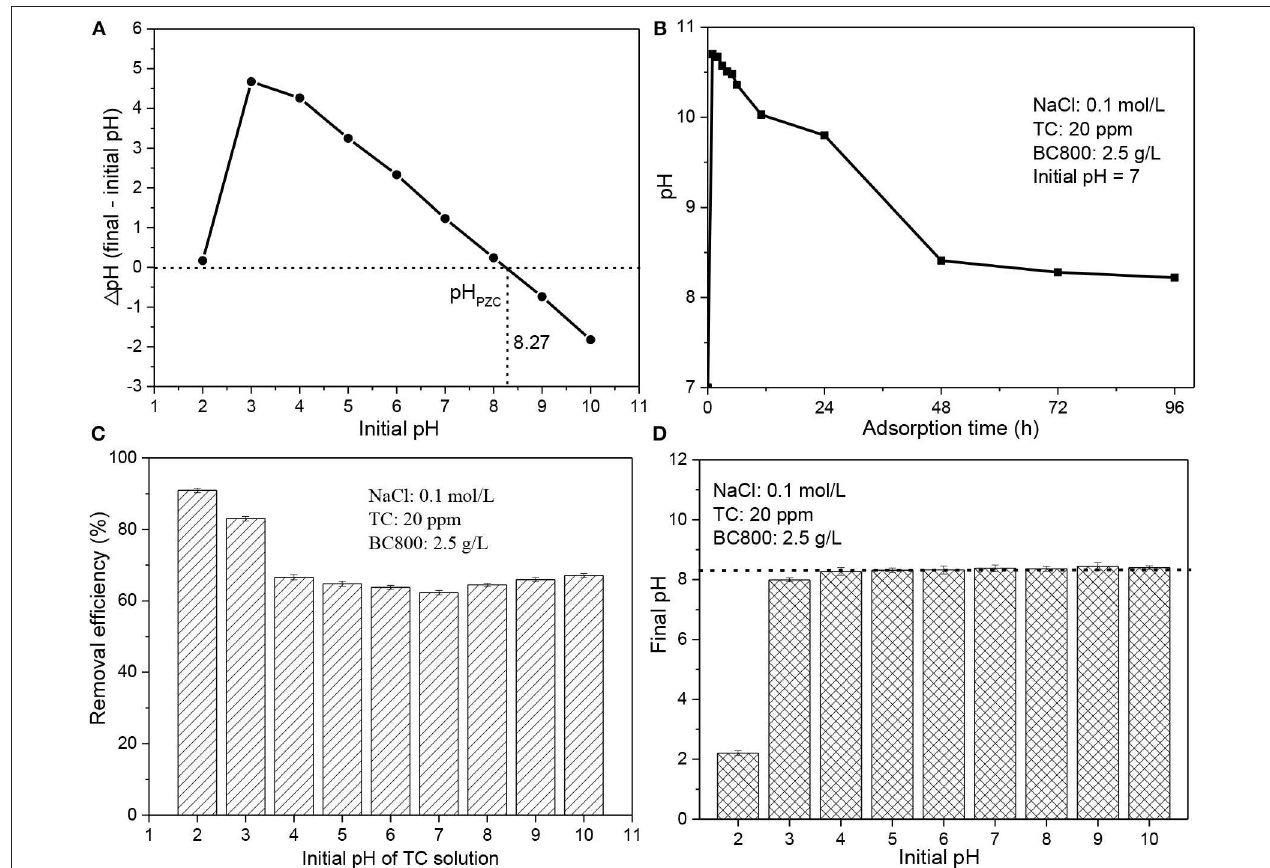
FIGURE 3 | (A) pH PZC of BC800; (B) the pH of TC solution with adsorption time; (C) adsorption performance of BC800 on TC solution with different initial pH; and (D) the final pH of TC solution after adsorption benchmarking against its initial pH. pH PZC stands for the pH of zero point charges; BC800 stands for biochar prepared at 800 ◦